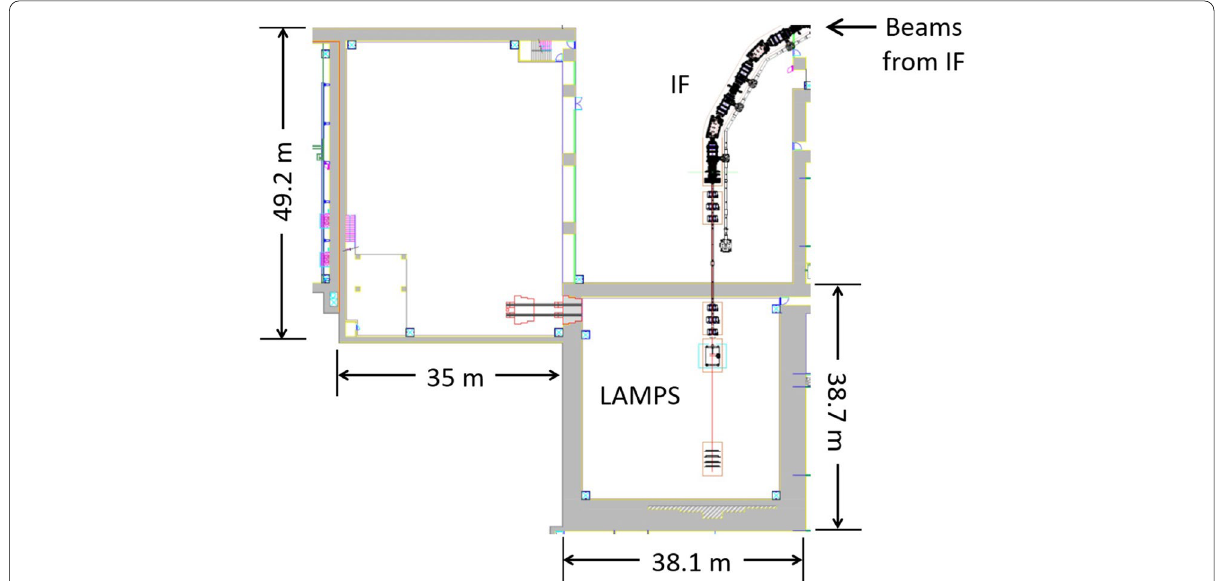
Fig. 14 Layout of the high-energy experimental halls for nuclear physics at RAON. Presently, the room on the right side is used for LAMPS, and the one on the left side is reserved for future